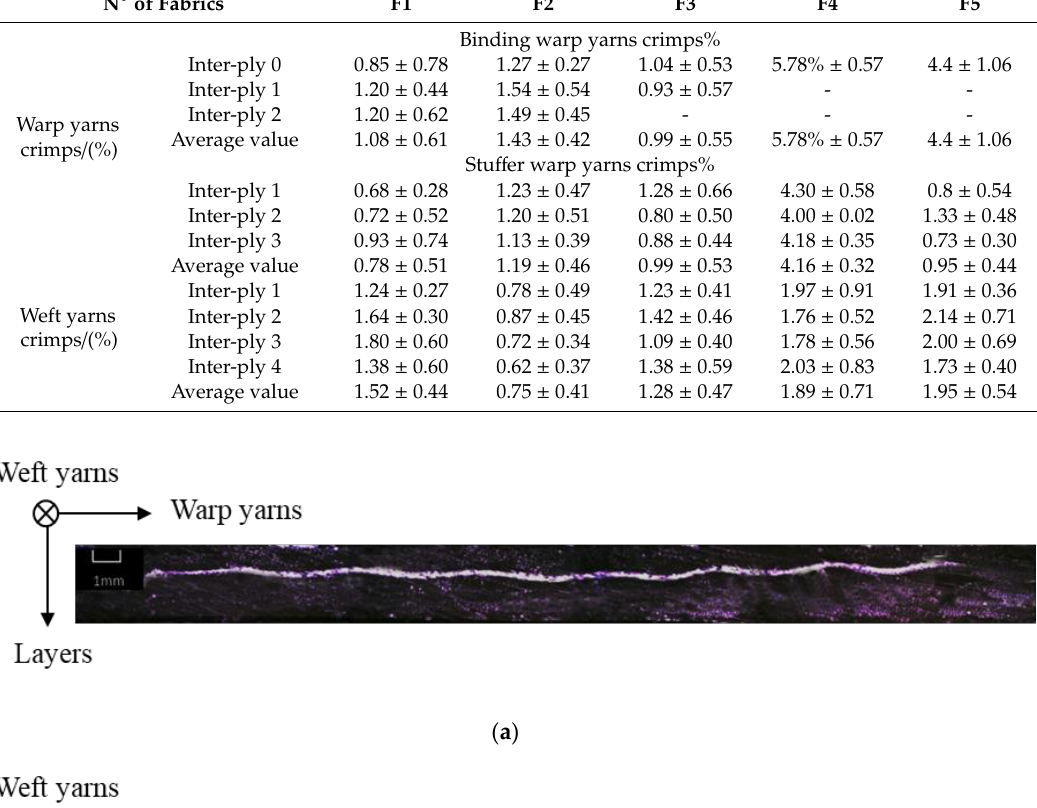
Table 4. Average crimp values of all warp and weft yarns for all the dry 3D warp interlock fabrics. N ◦ of Fabrics